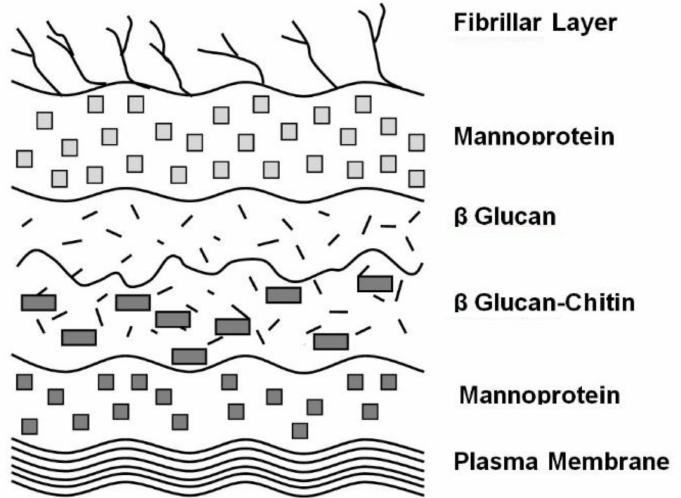
Figure 7. Schematic diagram of the architecture yeast cell wall. Components such as mannoprotein occur as a matrix and are distributed throughout the entire wall; therefore, the layered arrangement should show zones of enrichment